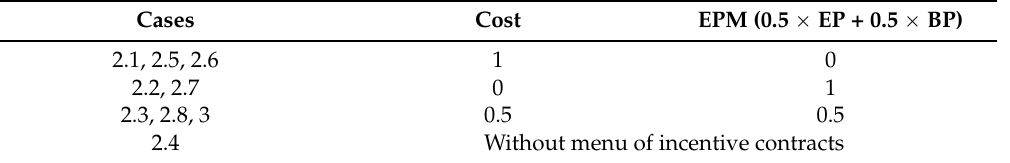
Table 5. Comparative results for Cases 2.1–2.3 and 2.5 (unit: $,). (Note: Y = saying “Yes” to offer of